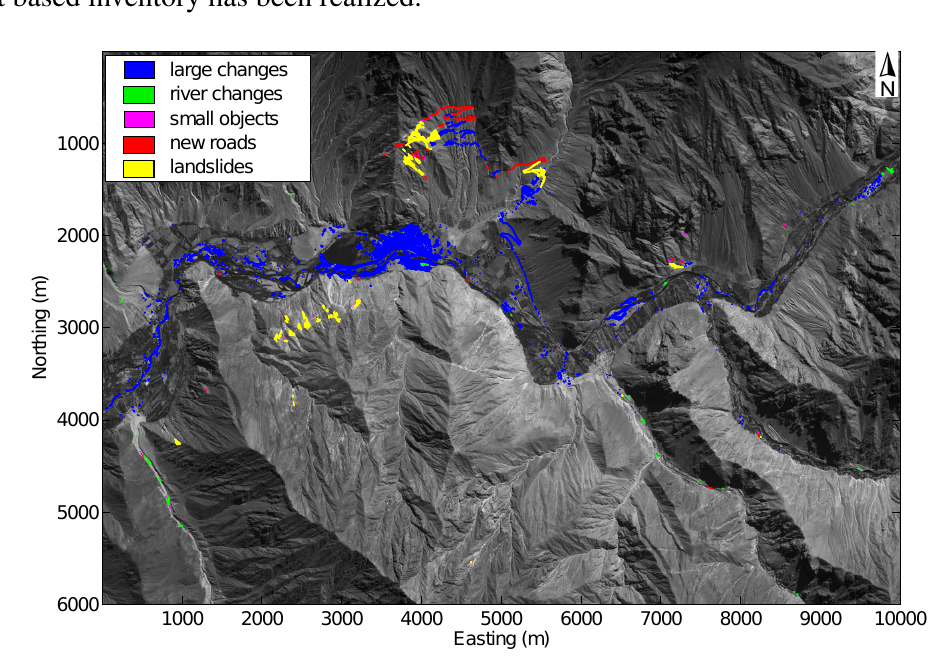
Figure 5. Results of the automatic classification for one subset image (area A2) where an expert based inventory has been